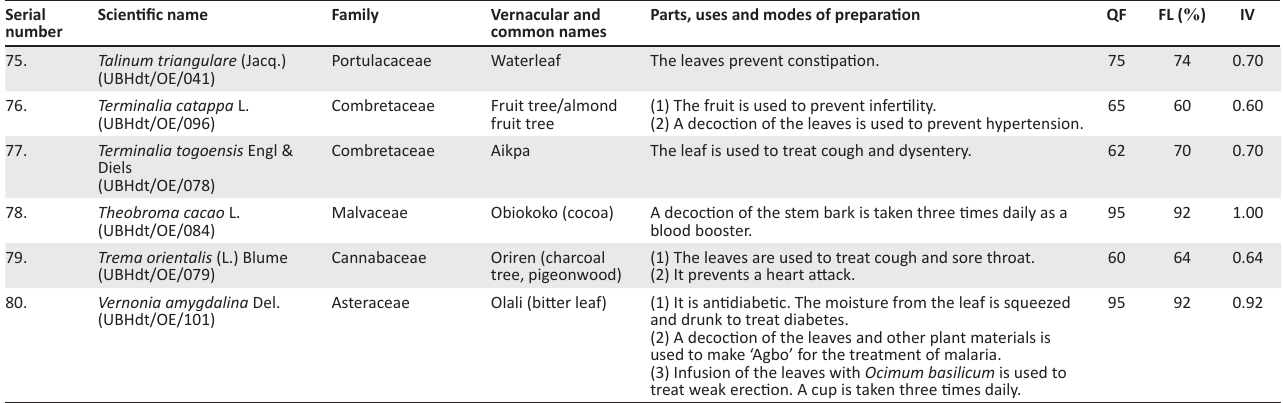
TABLE 1 (Continues...): List of plants with medicinal uses.